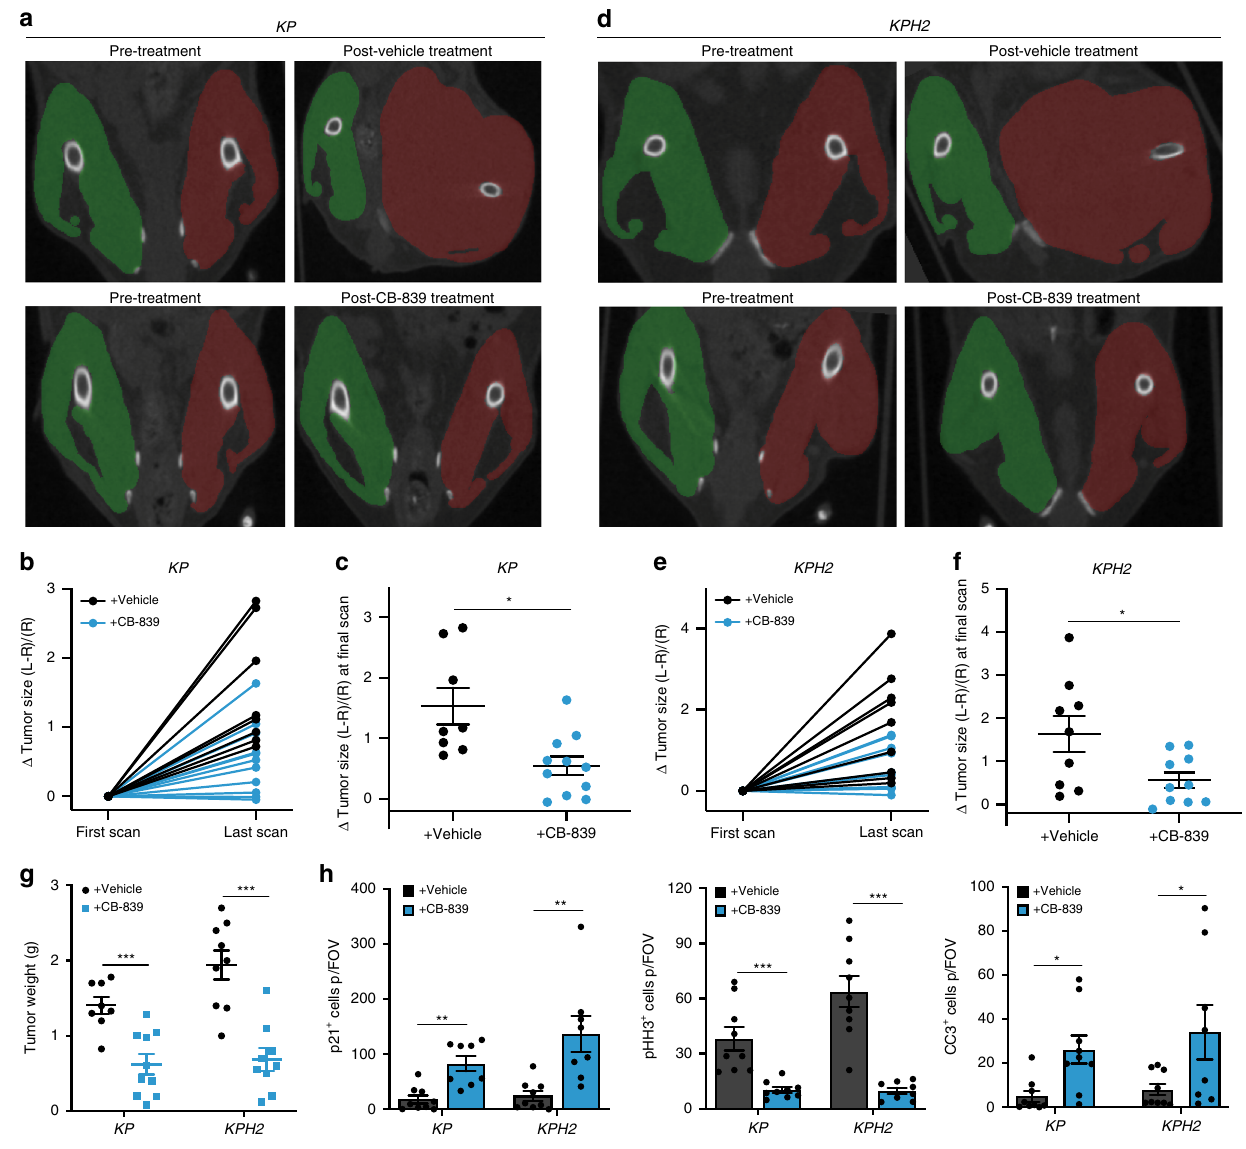
Fig. 7 CB-839 is effective in an autochthonous UPS model. a Representative computed tomography (CT) scans of KP mice pre- and post-treatment with vehicle ( n = 8) or CB-839 ( n = 10) following up to 16 days of treatment. Right control (green) and left tumour-bearing (red) limbs are highlighted. b Change in tumour size as quanti fi ed from the relative difference in size of the two limbs normalized to the control limb in KP vehicle- ( n = 8) or CB-839- treated ( n = 10) mice. c Change in tumour size at fi nal CT scan following vehicle ( n = 8) or CB-839 treatment ( n = 10) in KP mice. Error bars are ± s.d.; * p < 0.05. d Representative CT scans of KPH2 mice pre- and post-treatment with vehicle ( n = 9) or CB-839 ( n = 10) following up to 21 days of treatment. Right control (green) and left tumour-bearing (red) limbs are highlighted. e Change in tumour size as quanti fi ed from the relative difference in size of the two limbs normalized to the control limb in KPH2 vehicle- ( n = 9) or CB-839-treated ( n = 10) mice. f Change in tumour size at fi nal CT scan following vehicle ( n = 9) or CB-839 treatment ( n = 10) in KPH2 mice. Error bars are ± s.d.; * p < 0.05. g Tumour weights from vehicle- and CB-839-treated KP (vehicle n = 8; CB-839 n = 10) and KPH2 (vehicle n = 9; CB-839 n = 10) mice. Error bars are ± s.e.m.; *** p < 0.0005. h Quanti fi cation of p21 + , phospho-histone H3 + (pHH3), and cleaved-caspase 3 + (CC3) cells per fi eld of vision (FOV) in vehicle- and CB-839-treated animals (left to right). N = 8 with fi ve images taken per section. Data represent mean ± s.e.m.; * p < 0.05, ** p < 0.005, *** p < 0.0005. p -Values were calculated from a two-tailed Student ’ s t -test for c , f – h . Source data are provided as a Source Data fi